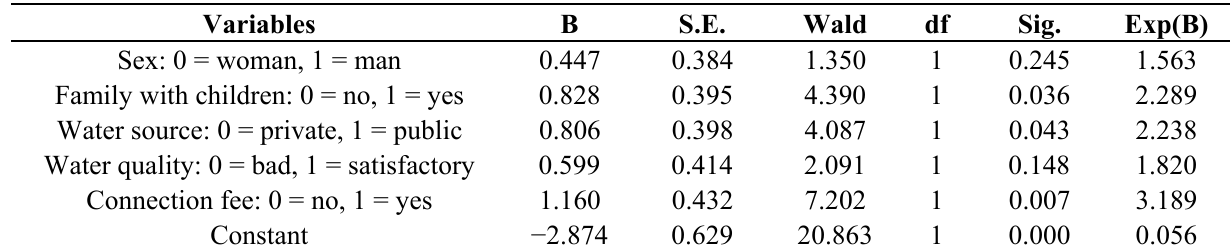
Table 5. Explanatory variables for private